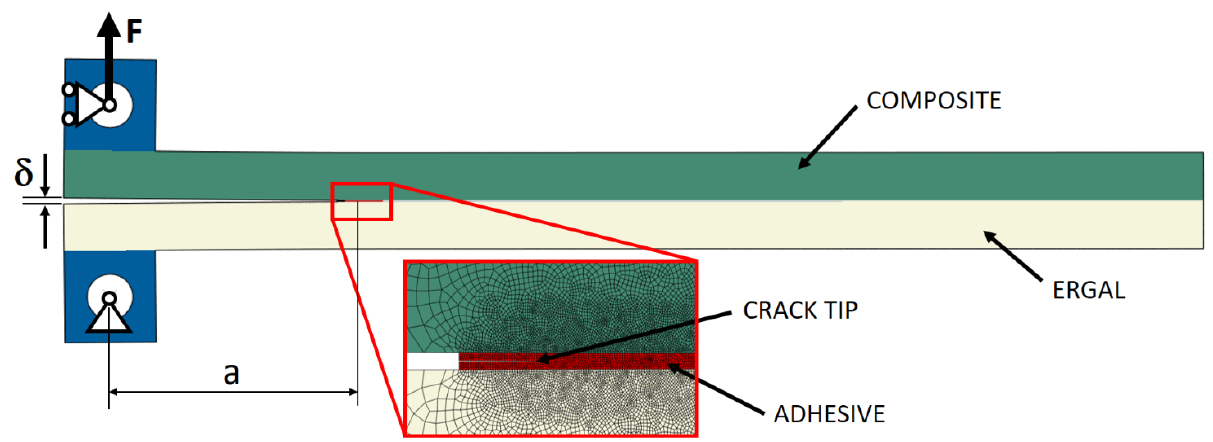
Figure 4. Details of the FE model for the DCB joints.